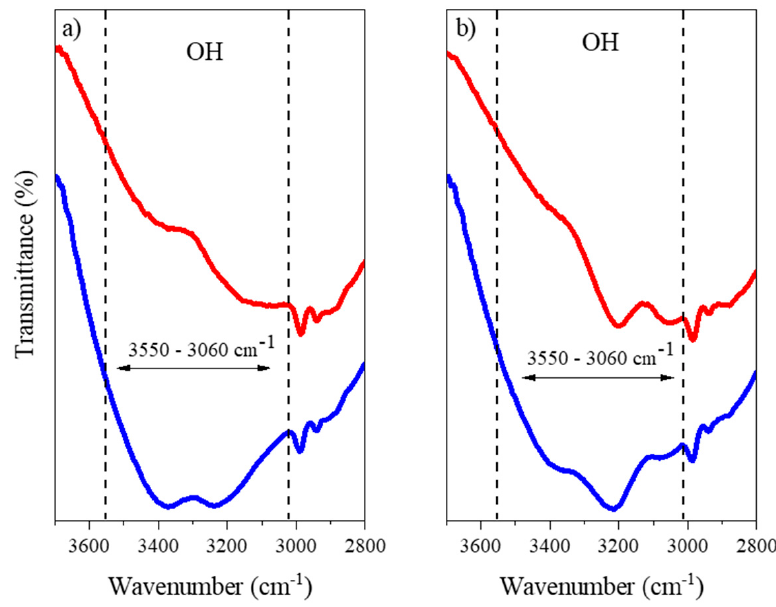
Figure 4. FTIR spectra characterizing O–H stretching. ( a ) FTIR spectra of — (red line) lactic acid:glycine, — (blue line) lactic acid:glycine:water. ( b ) FTIR spectra of — (red line) lactic acid: ammonium acetate, — (blue line) lactic acid:ammonium acetate:water.